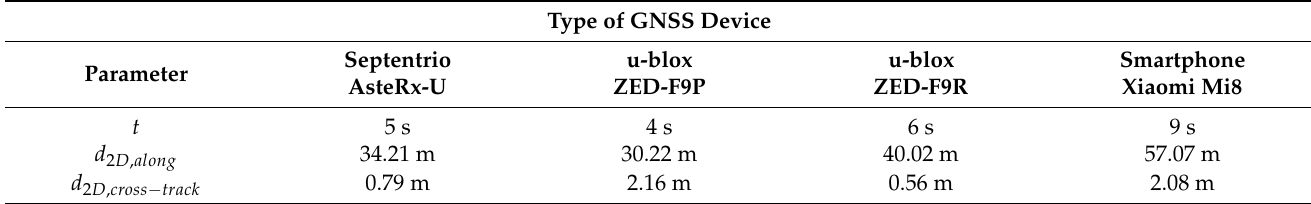
Table 8. Time of reacquisition of position ( t ) , distance along track from tunnel exit ( d along ) , and